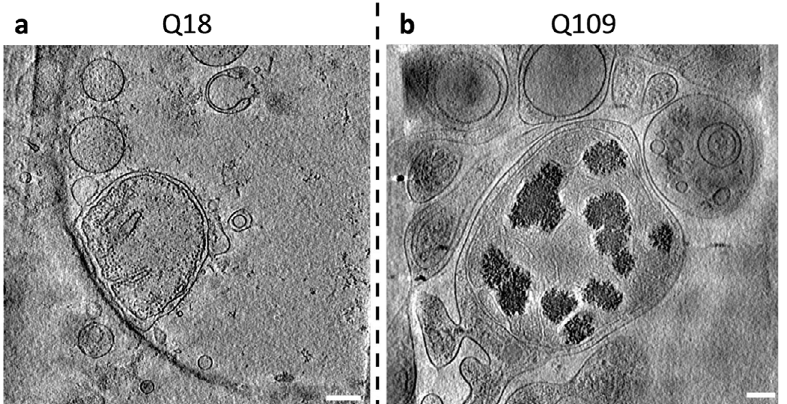
Fig.6|Massspectrometryofisolatedmitochondriarevealeddifferentlevelsof associated proteins in neurites of iPSC-neurons (Q109) vs controls with representative cryoET of isolated HD mitochondria. Z-slices (~1.4nm thick) of a control Q18 and b Q109 mitochondria showing abnormal accumulation and enlargement of mitochondrial granules in the latter. Scale bar=100nm. Most of the mitochondria from Q109 have aberrant cristae and no granules as shown in